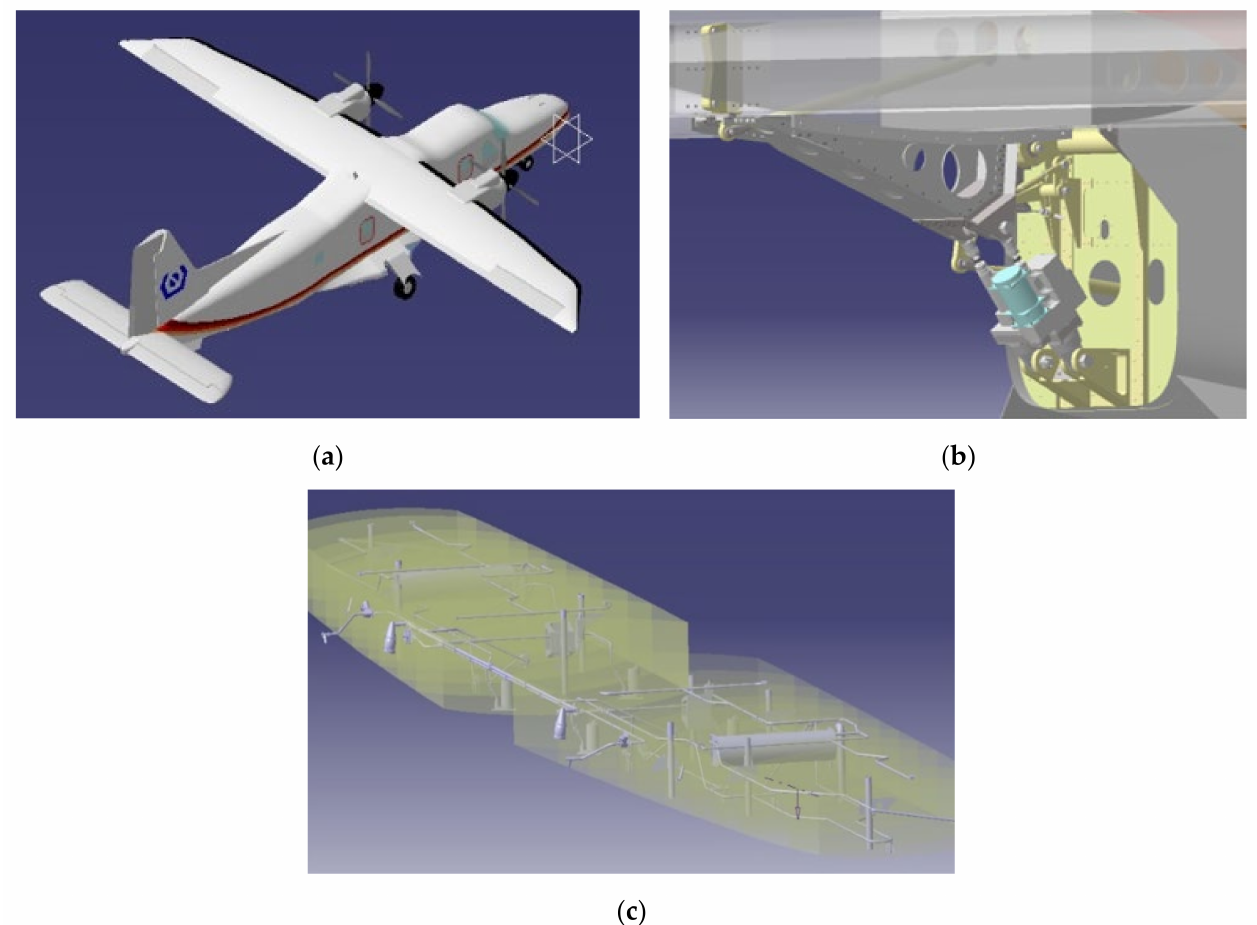
Figure 3. 3D modeling: ( a ) 3D model of the Dornier 228; ( b ) The components use to connect fuselage with horizontal stabilizer; ( c ) 3D model of the Dornier 228 (cid:48) s fuel